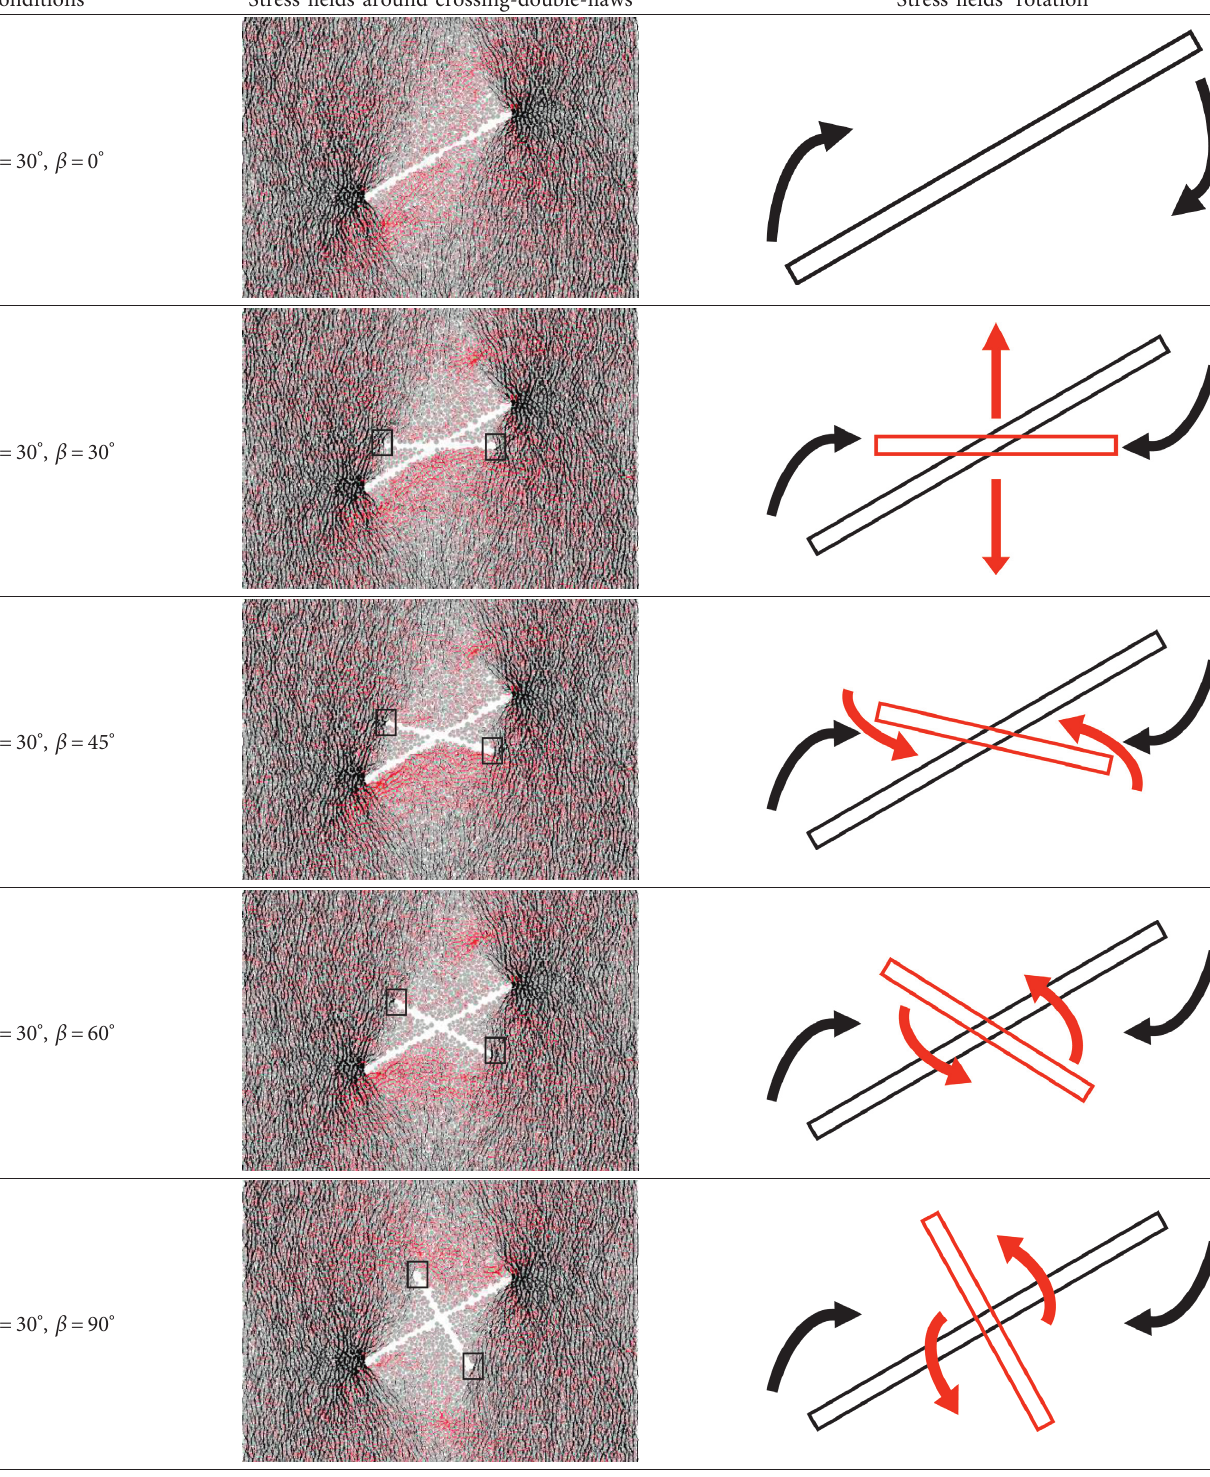
Table 4: Force concentrations around the crossing-double-flaws at α of 30 ° when the initiation of first macrocracks. Conditions Stress fields around crossing-double-flaws Stress fields’